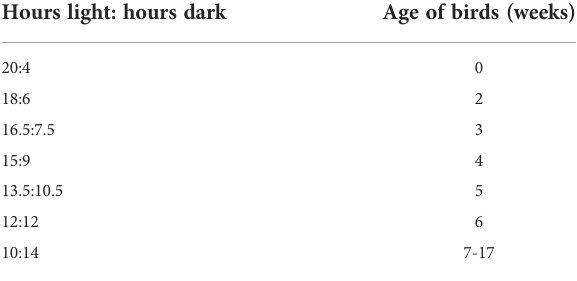
Tableofthelightingscheduleduringtherearingphase.Adaptedfromstandardguidelines for Hy-Line Brown hens.